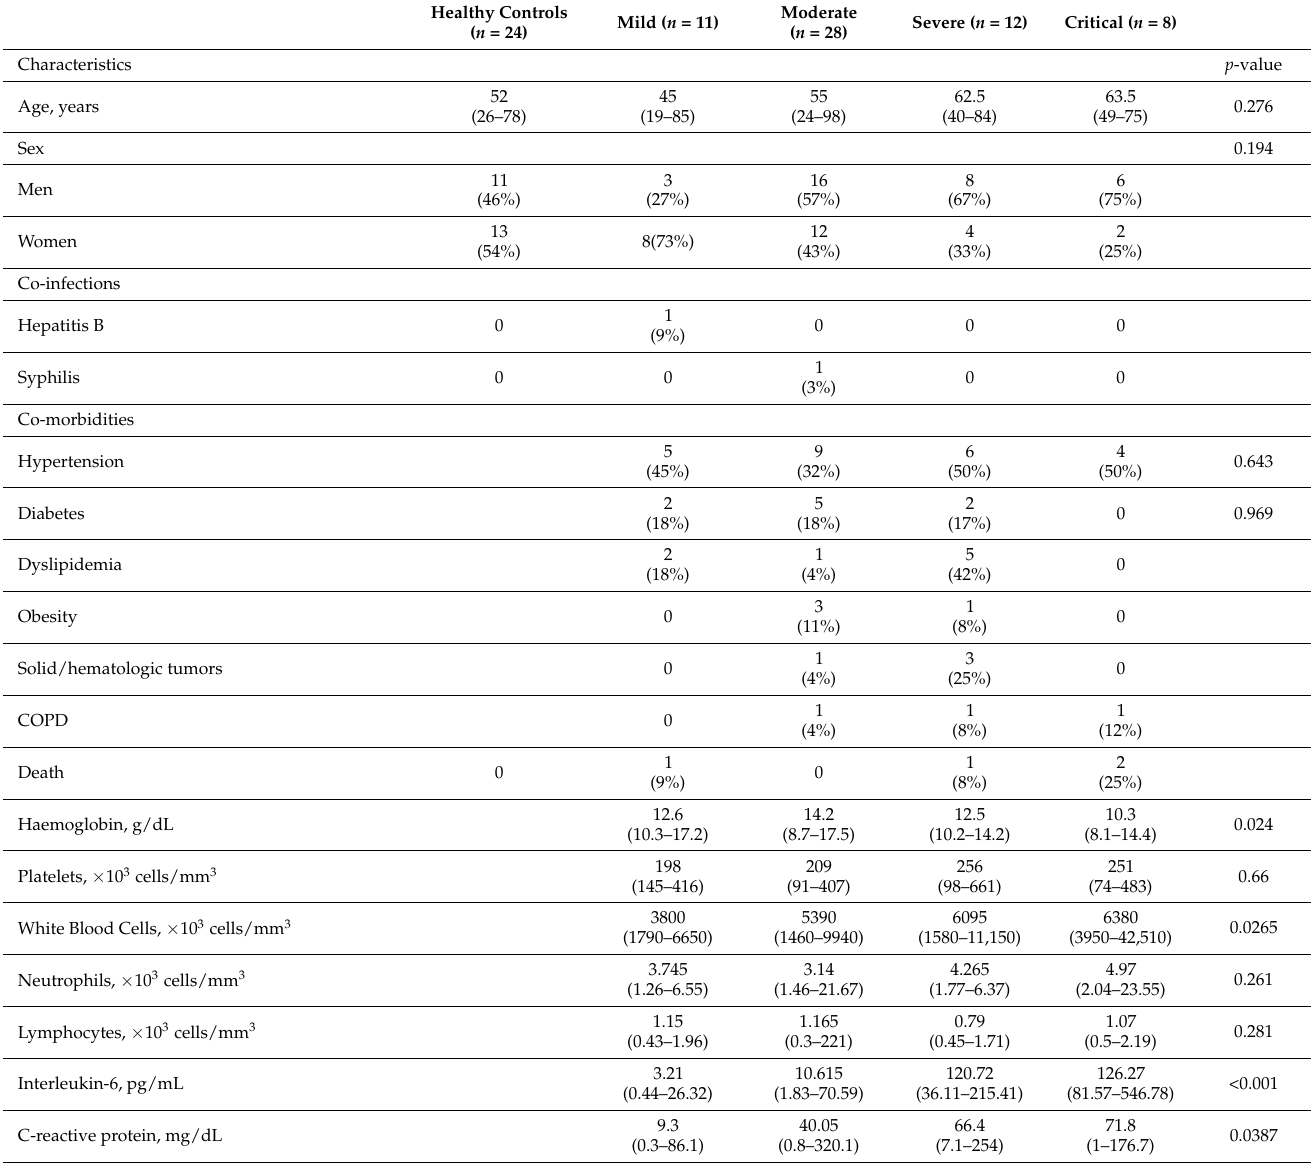
Table 1. Clinical and biochemical assessments of study participants. Data were median (min-max) or n (%); p -values comparing the disease groups were calculated using Kruskal Wallis ANOVA test (age, hemoglobin, platelets, white blood cells, neutrophils, lymphocytes, interleukin-6, C-reactive protein, D-dimer, lactate dehydrogenase, serum creatinine, aspartate aminotransferase, alanine aminotransferase, gamma-glutamyl transpeptidase, ferritin) or the chi-squared test (sex, co-infections,